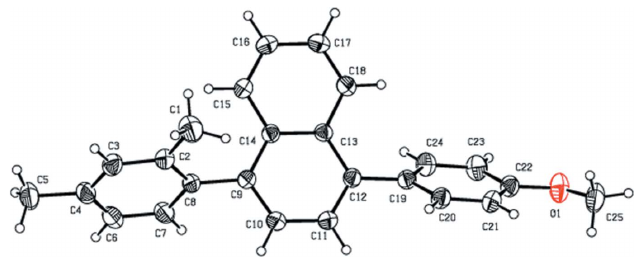
Figure 1 The molecular structure of the title compound, with the atom labelling. Displacement ellipsoids are drawn at 50% probability level.